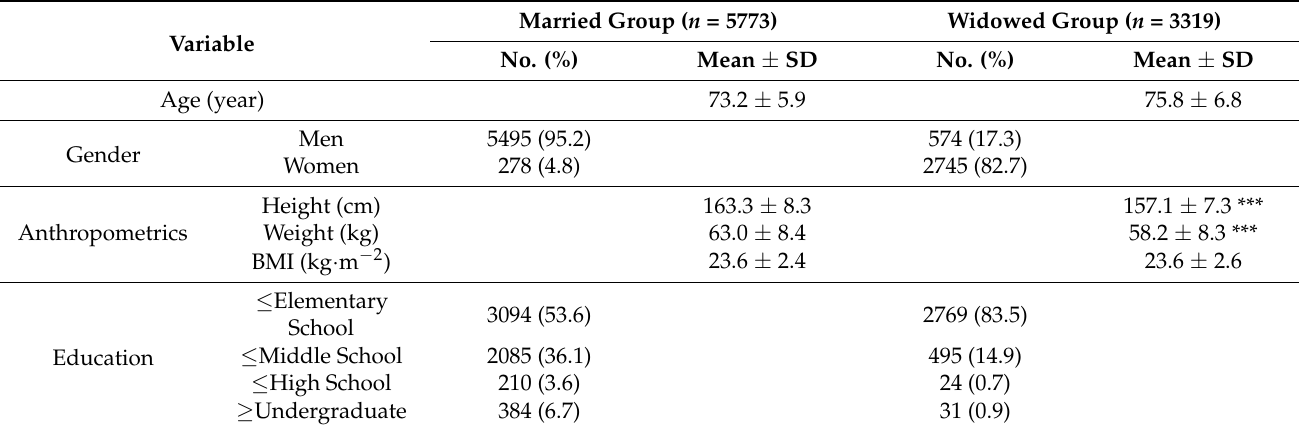
Table 1. Participants’ characteristics and anthropometrics information.